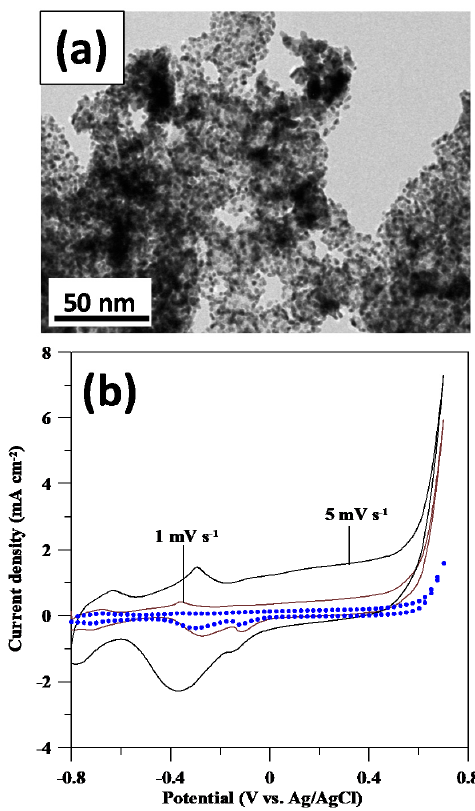
Figure 5. ( a ) HR-TEM micrographs of Pt-GS sample and ( b ) cyclic voltammetry (CV) profiles of Pt-GS catalyst electrode in 0.1 M NaOH + 0.1 M glucose at 1 and 5 mV·s − 1 . The symbols represent the CV profile measured at 1 mV·s − 1 in 0.1 M NaOH without glucose.